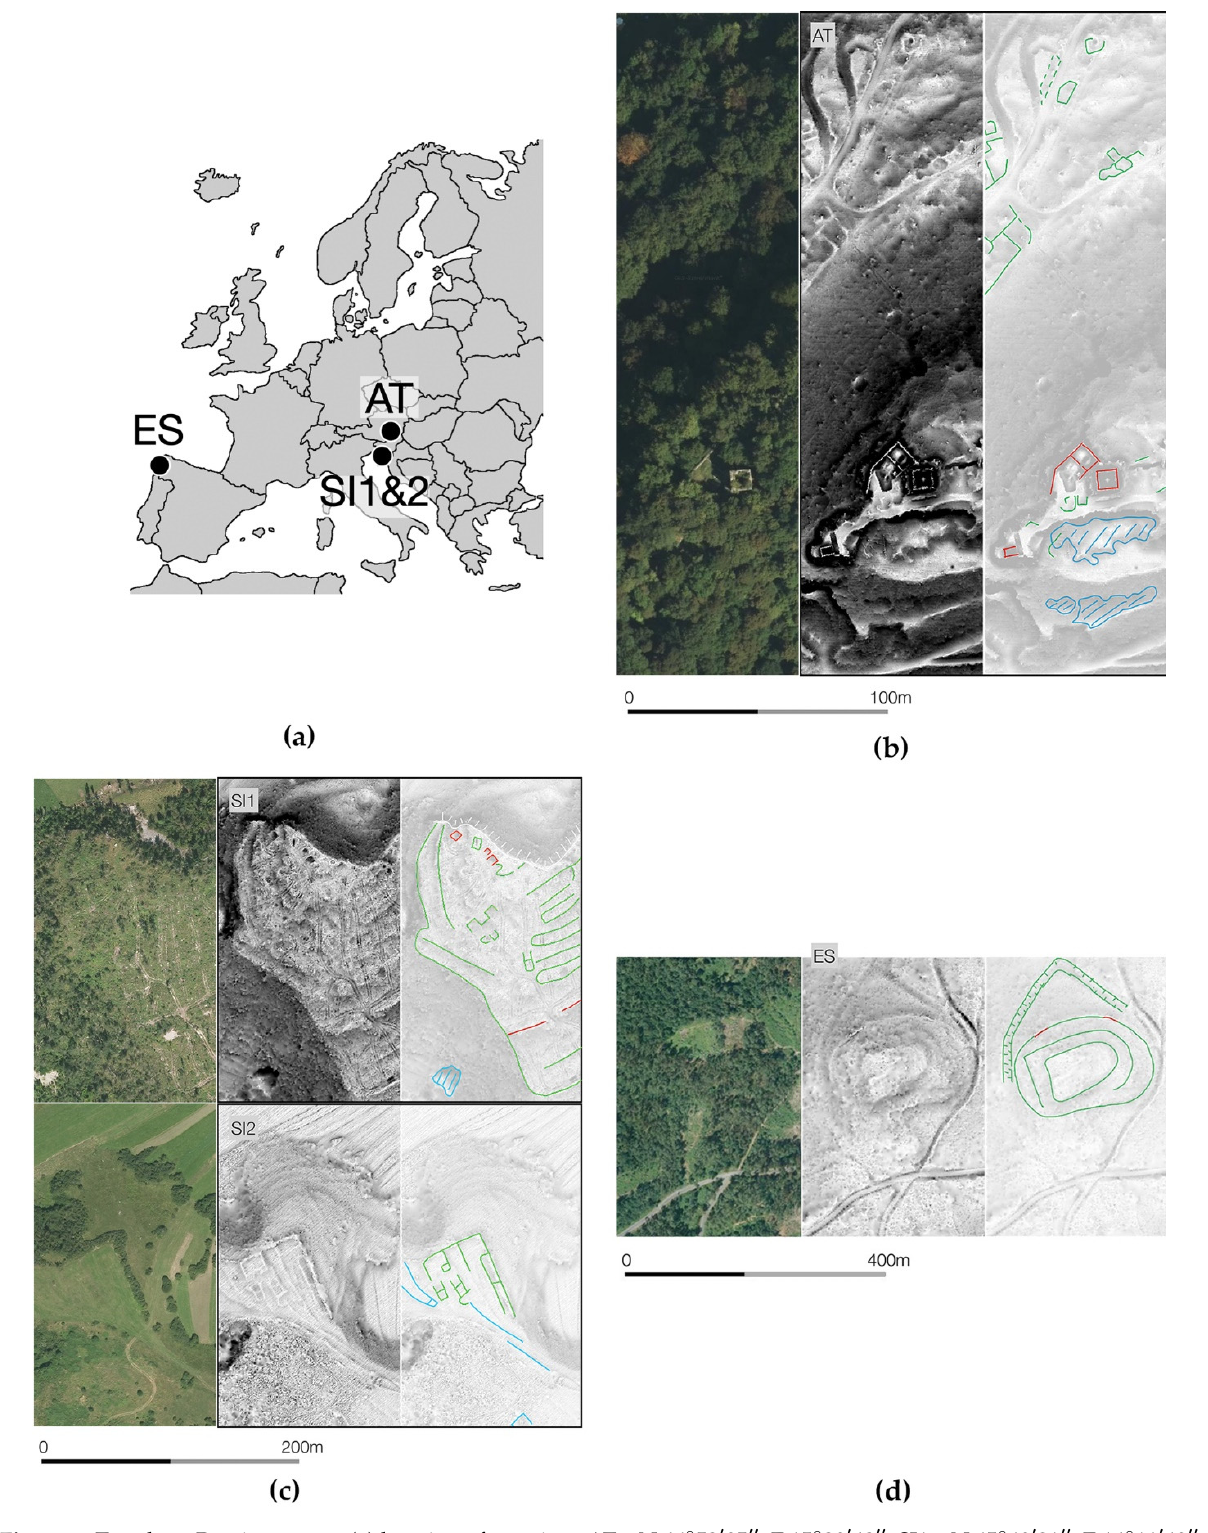
Figure 3. Test data. Previous page: ( a ) location of test sites: AT—N 46°53’05”, E 15°30’48’’, SI1—N 45°40’21”, E 14°11’40’’, SI2—N 45°40’56”, E 14°12’25”, ES—N 42°44’30”, E 8°33’02”; ( b ) test site AT. This page: ( c ) test sites SI1 and SI2; ( d ) test site ES. (b, c, d): shown at 100% crop size; left—digital orthophoto; middle—sky view factor visualization of manually processed DFM; right—archaeological features (blue—embedded features, green—partially embedded features, red—standing features). (After [20]: Figure 1, published under CC-BY 4.0).